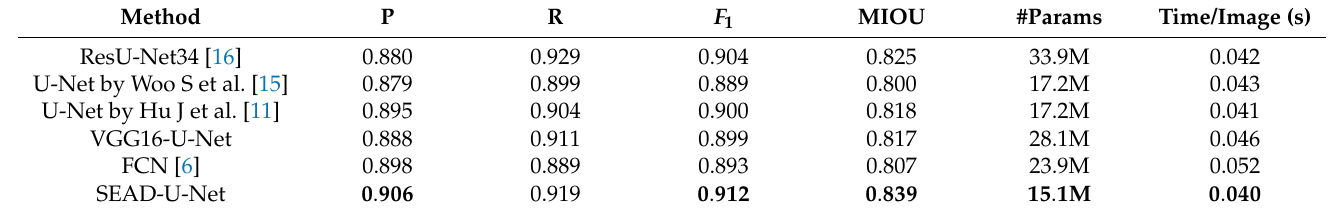
Table 2. Experimental results of segmentation on CCIC dataset.